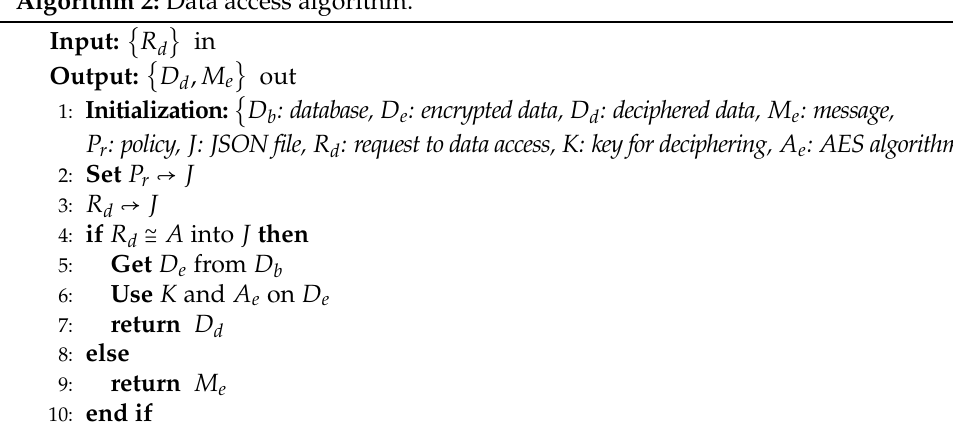
Algorithm 2: Data access